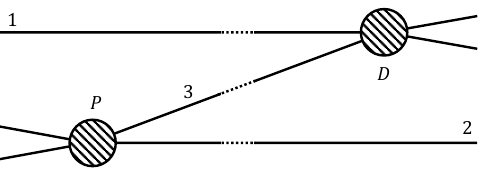
Figure 1. A particle, labelled ‘3’, is produced in an interaction ( P ), propagates over a large distance, and is detected in a second interaction ( D ). Particles labelled by ‘1’ and ‘2’ only participate in the interactions D and P ,